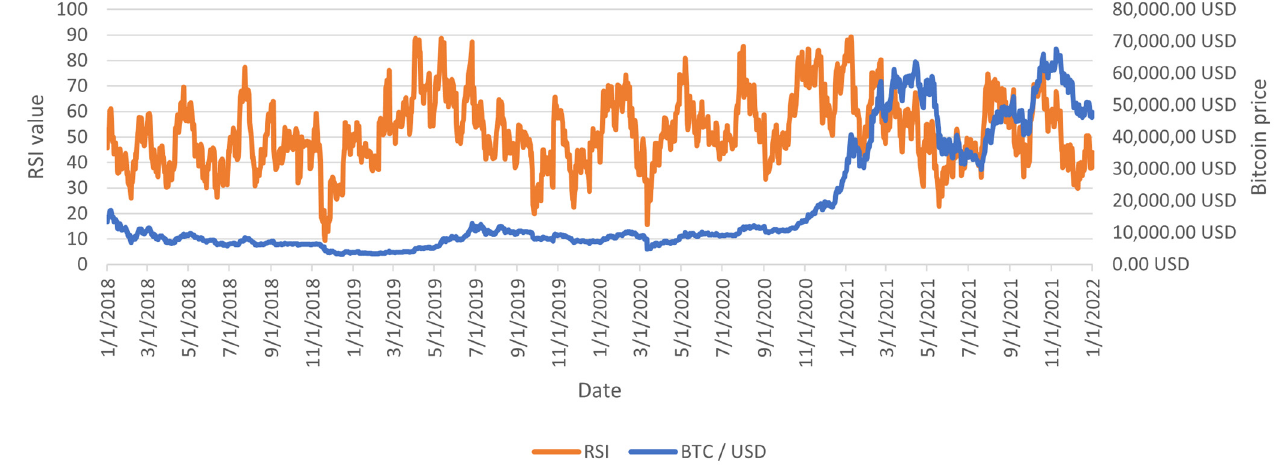
Figure 2. The Relative Strength Index calculated with close as input for Bitcoin on 1D interval.